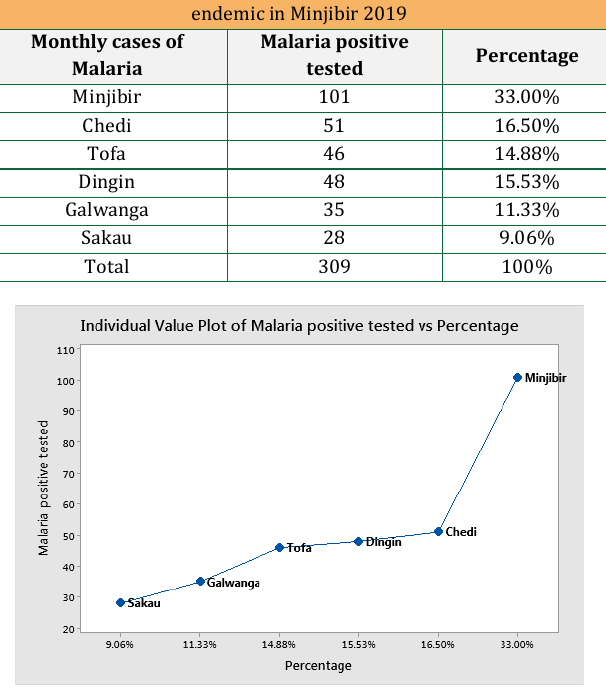
Figure 6: One-way ANOVA at 0.05 significant levels in 2019